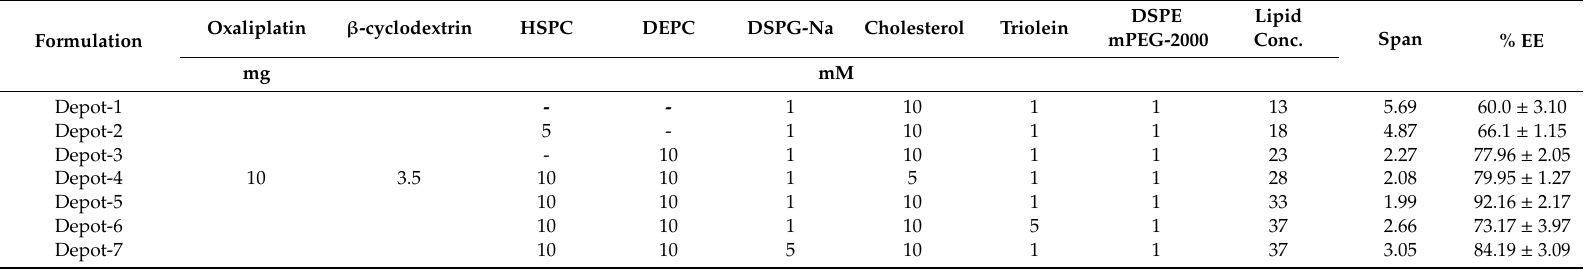
Table 1. Compositions of oxaliplatin-loaded multivesicular liposome (MVL) depot formulations. HSPC: hydrogenated soybean phosphatidylcholine, DEPC: